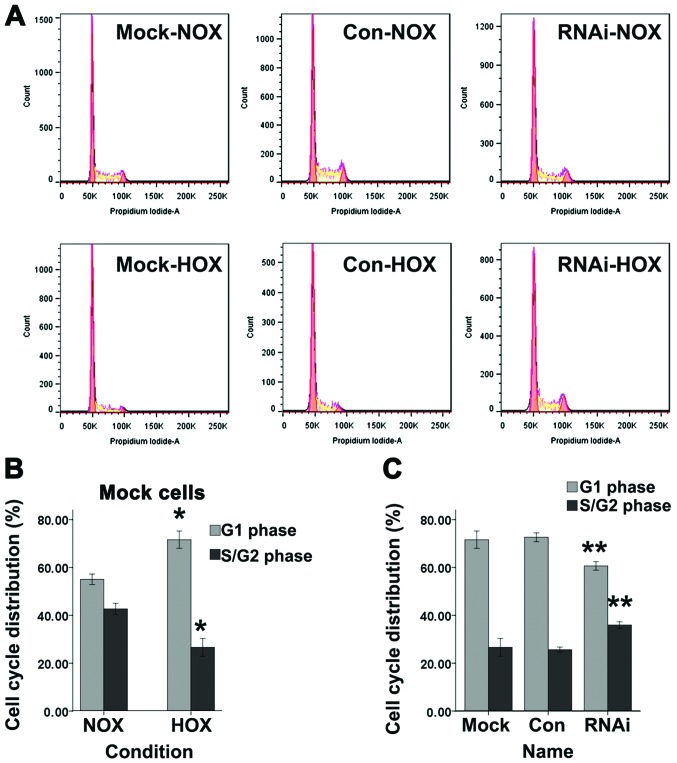
The effect of HIF-1α on cell cycle of SCC-15 cells. (A) Cell cycle of the Mock, Con and RNAi cells were tested by FACS. (B) DFO can significantly increase the number of G1 phase cells and decreased the number of S/G2 phase cells. (C) SCC-15 cells treated with lentiviral vector targeting HIF-1α showed a significant increase on G1 phase cells, and a significant decrease on S/G2 phase cells (bars, ± SD, *p<0.05, compared to normoxic Mock cells, **p<0.05, compared to Mock and Con cells). NOX, normoxia; HOX, hypoxia.